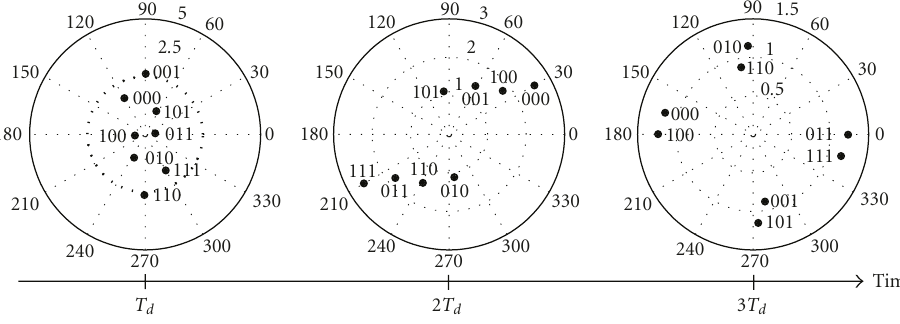
Figure 8: Consecutive joint constellations of